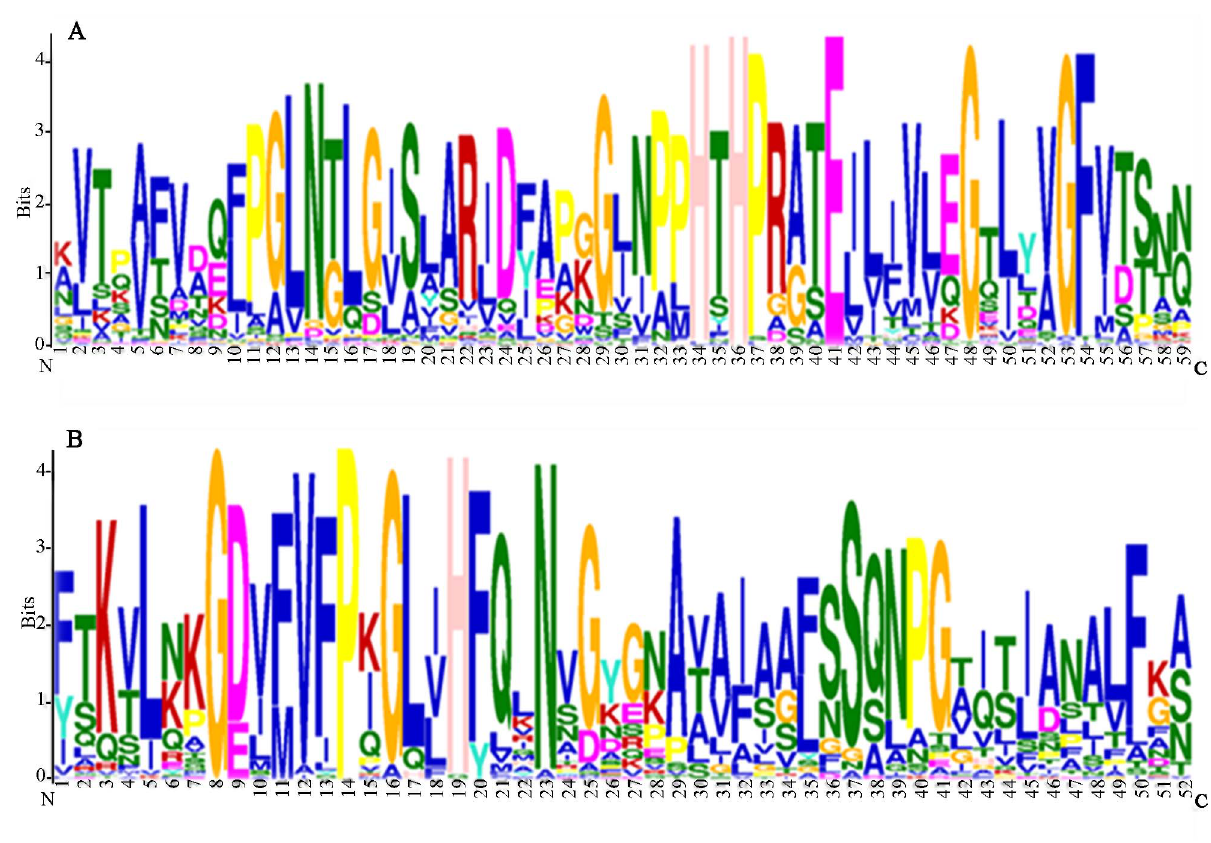
Figure 1. Conserved domains across cupin proteins in soybean. The sequence logos are based on alignments of 69 Gmcupin domains. Multiple alignment analysis of all typical Gmcupin domains (A: Gmcuppin 1; B: Gmcupin 2) were performed with Clustal W. The bit score indicates the information content for each position in the sequence.